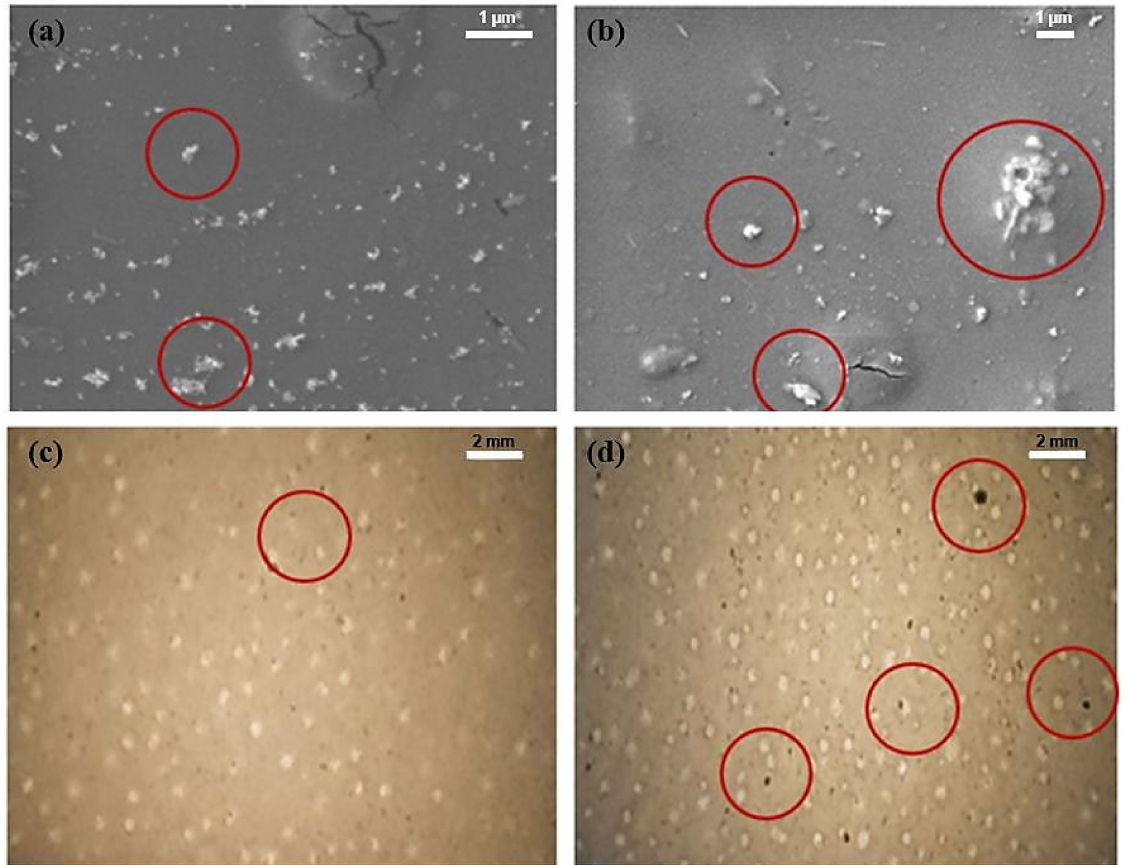
Figure 8. Undissolved calcium peroxide particles: ( a ) SEM image of low calcium peroxide concentra- tion at a magnification of × 15,000 and an energy of 5.0 keV; ( b ) SEM image of high calcium peroxide concentration at a magnification of × 7500 and an energy of 5.0 keV. Optical image of the composite at ( c ) low and ( d ) high calcium peroxide concentration at a magnification of ×